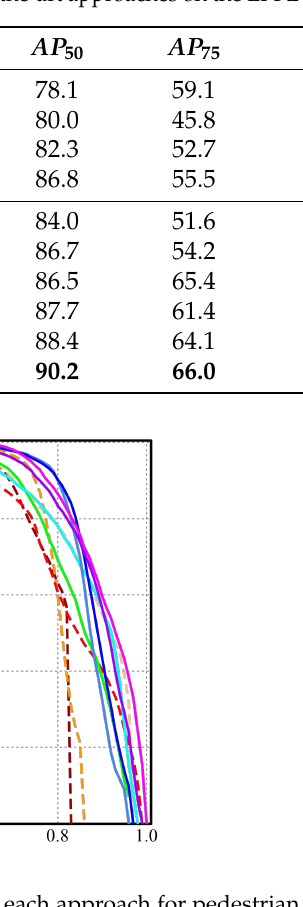
Table 2. Comparison with the state-of-the-art approaches on the EPFL dataset for pedestrian detection.